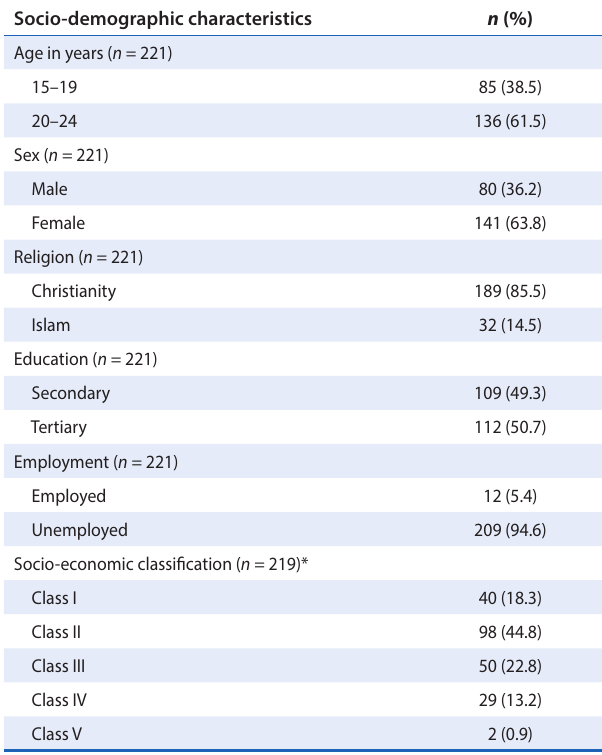
*Two respondents were orphans and were not captured by the Oyedeji et al. criteria.